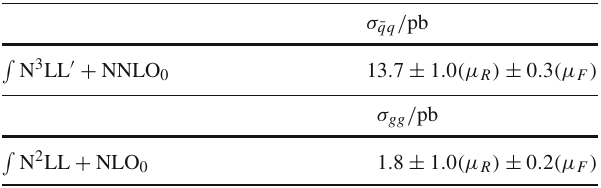
Table 2 Cross-sections at 8 TeV for q ¯ q and gg hard-function initiated γ (cid:9) and smooth-cone processes with μ R = (cid:8) q T